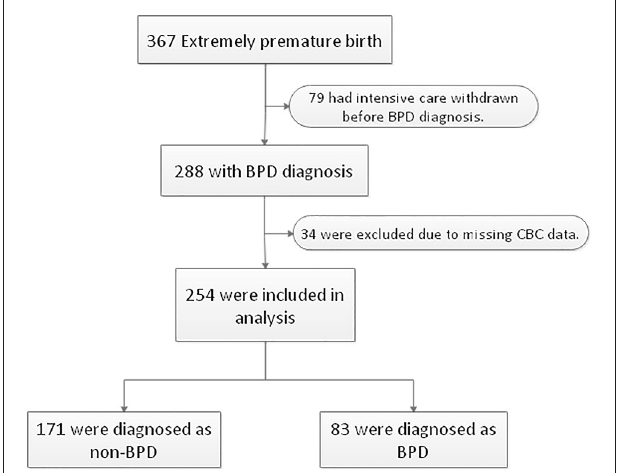
FIGURE 1 | Flowchart of case selection and analysis. Two hundred fifty-four extremely premature infants were enrolled in this study. BPD, bronchopulmonary dysplasia. CBC, complete blood